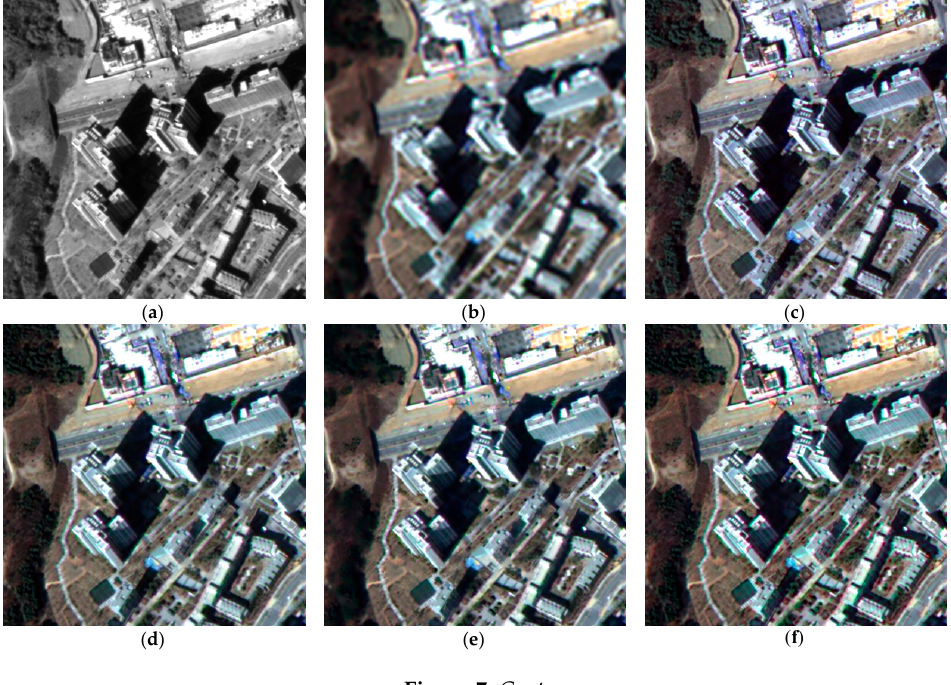
( i ) Figure 7. The 400 × 400 details of KOMPSAT-3 true-color (red, green, and blue) composites: ( a ) panchromatic image; ( b ) EXP ; ( c ) GIHS ; ( d ) GSA G ; ( e ) GSA L ; ( f ) BDSD ; ( g ) NNDiffuse ; ( h ) HP-NDVI spectral ; ( i ) HP-NDVI spatial .